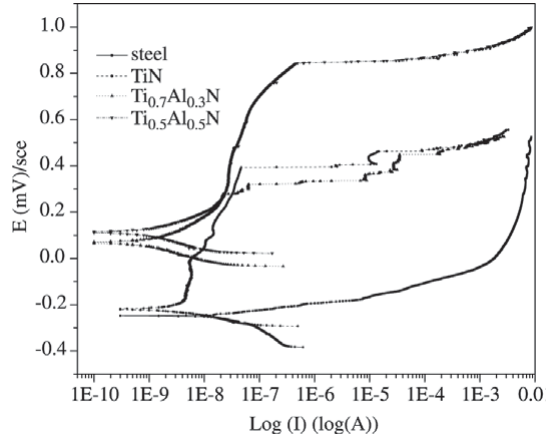
Figure 9. Polarization curves of steel without and with coatings in solution 0.5 M NaCl at ambient temperature.